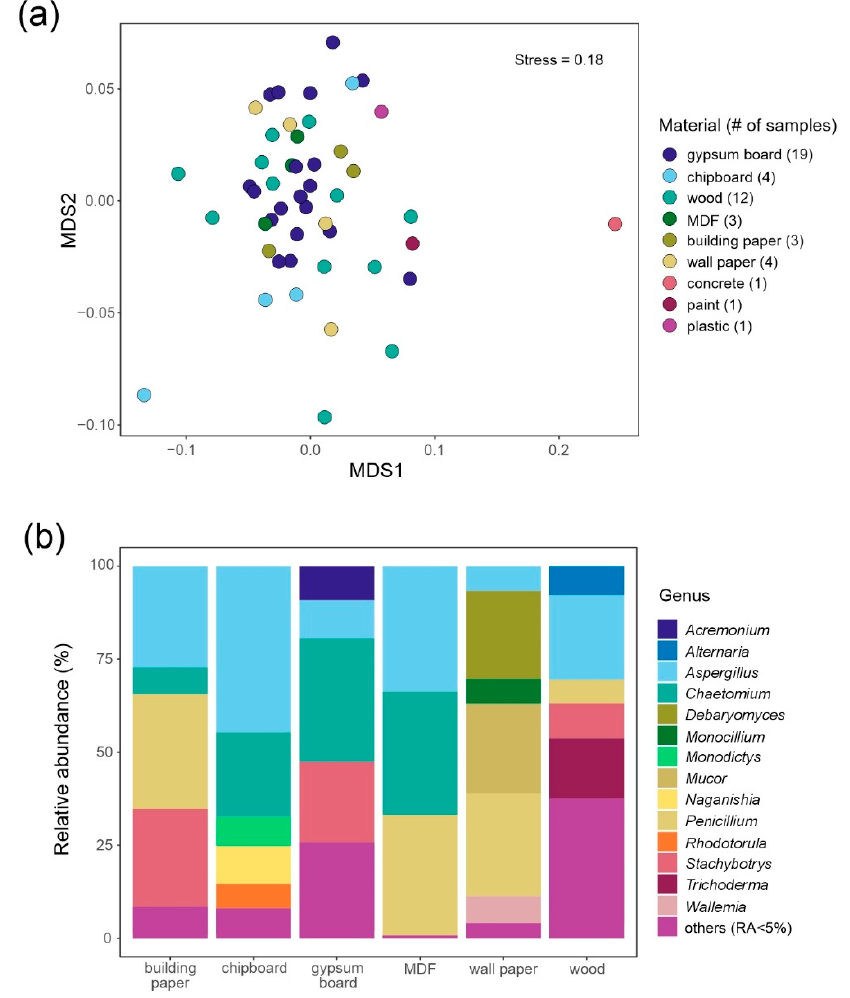
Figure 3. Mold mycobiota, as revealed by DNA metabarcoding: ( a ) NMDS plot comparing the fungal community composition in 48 mold samples collected from different materials; ( b ) the most abundant fungal genera (RA ≥ 5%) identified in the mold samples collected from different materials, excluding those materials represented by a single sample, i.e., concrete, paint, and plastic.